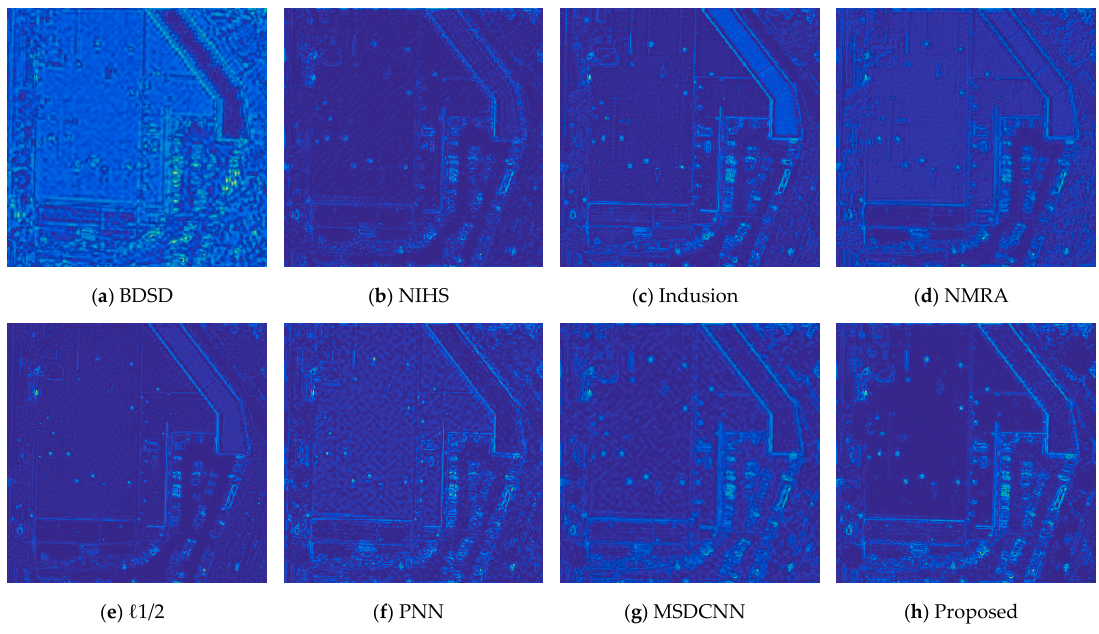
Figure 9. The residual images corresponding to Figure 8. ( a ) BDSD; ( b ) NIHS; ( c ) Indusion; ( d ) NMRA; ( e ) (cid:96) 1/2; ( f ) PNN; ( g ) MSDCNN; ( h ) Table 2. Performance indictors at original scale on WorldView-2 dataset.